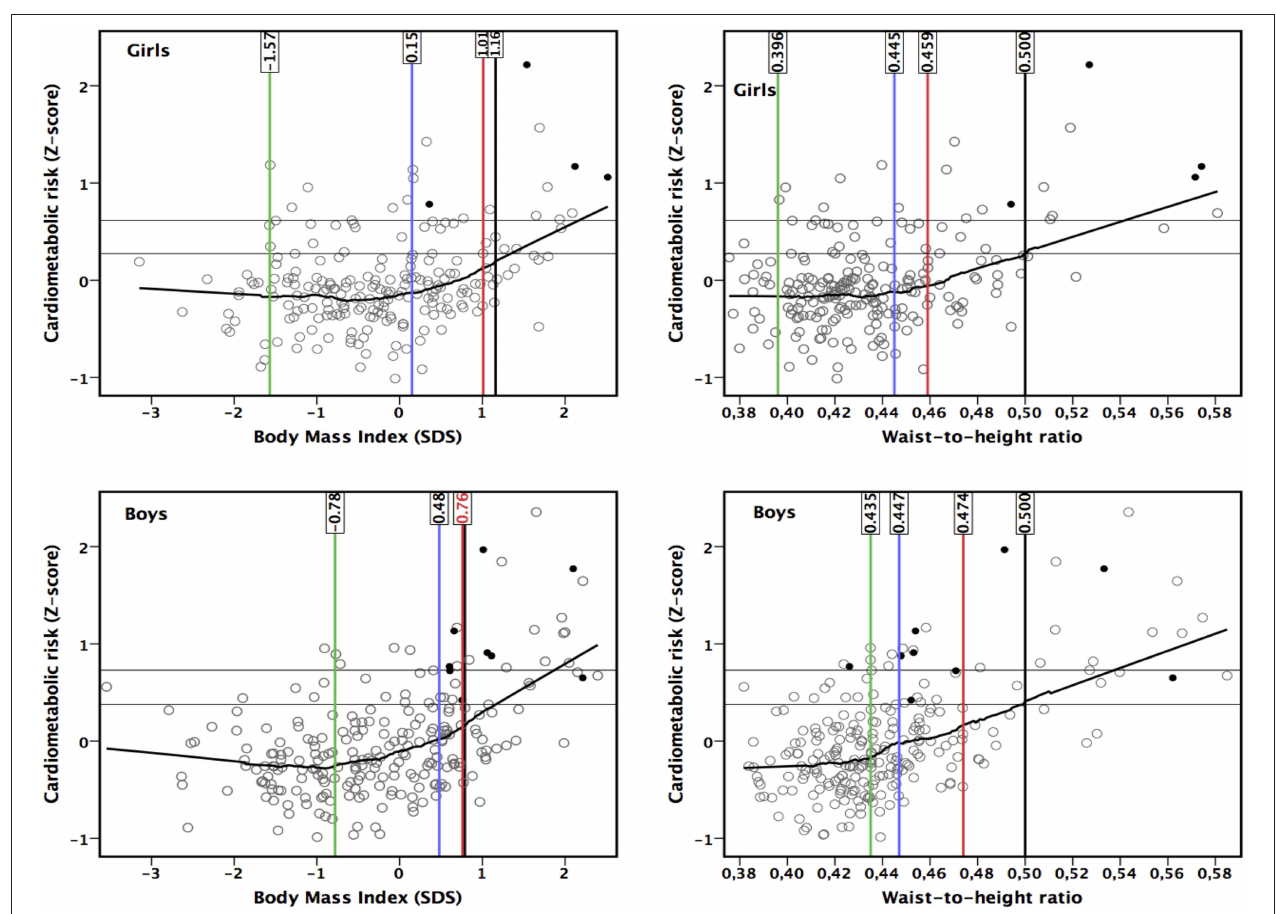
FIGURE 2 | Associations of body mass index standard deviation score (SDS) and waist-to-height ratio with cardiometabolic risk score (components were serum insulin and plasma high-density lipoprotein cholesterol, triglycerides, gamma-glutamyl transferase, high-sensitivity C-reactive protein, and uric acid). Black dots represent children with metabolic syndrome ( 33). Horizontal lines describe the 80 and 90th percentiles for cardiometabolic risk score. Vertical lines represents the threshold by negative likelihood ratio ( < 0.20) (green line), the point where sensitivity equals with specificity (blue line), the threshold by positive likelihood ratio ( > 5) (red line), and the traditional national criteria ( 30) (black